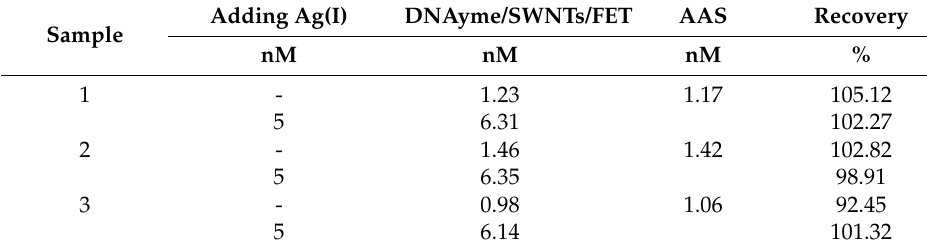
Table 2. Results of the Ag(I) recovery experiments in river water using the proposed biosensor.